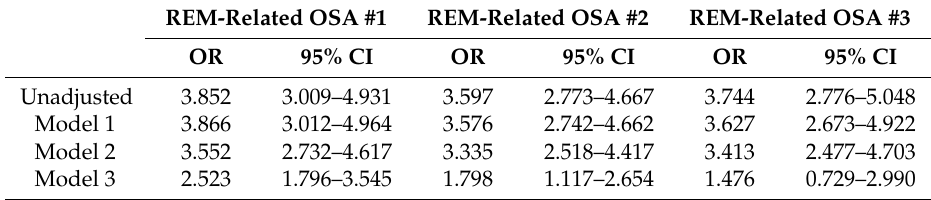
Table 5. Association between REM-related OSA and women aged over 50